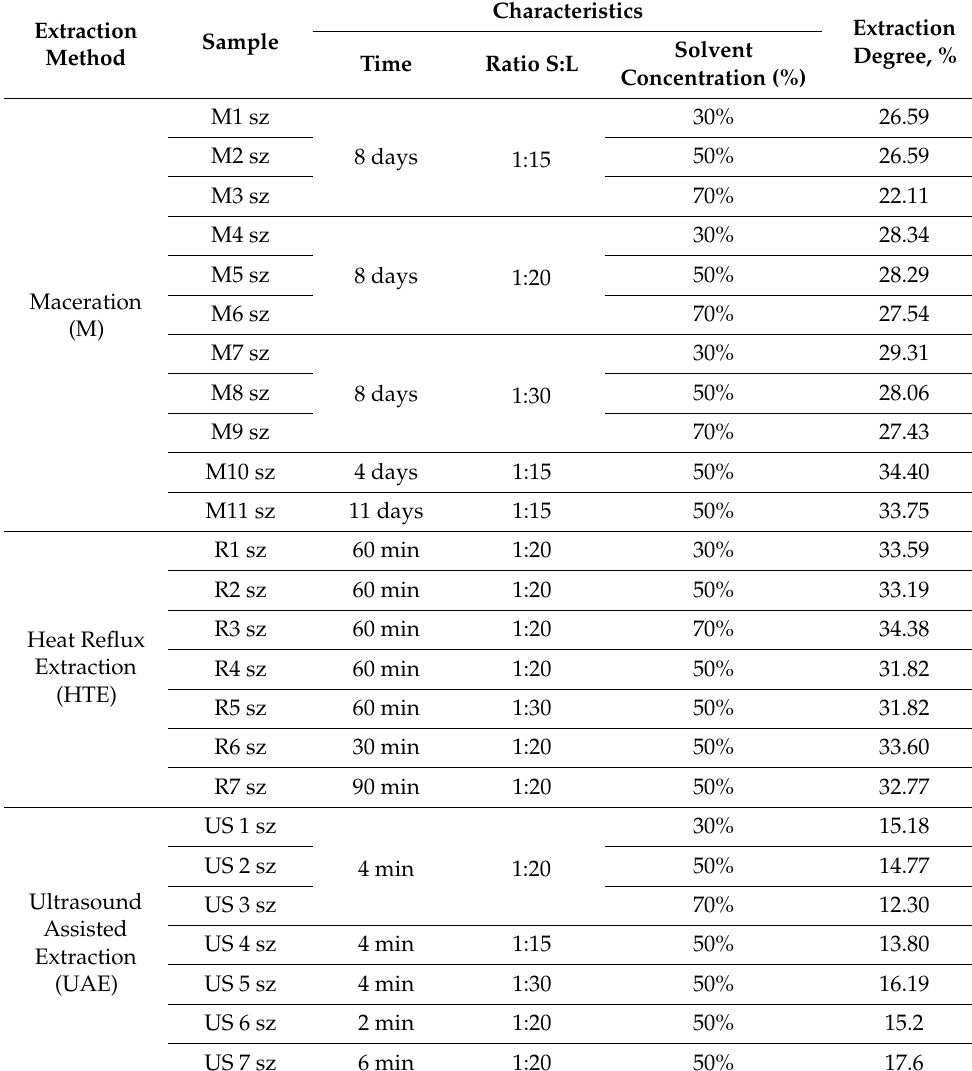
Table 3. Degree of extraction obtained in liquid-solid extraction methods used, in the case of the dry Galium verum